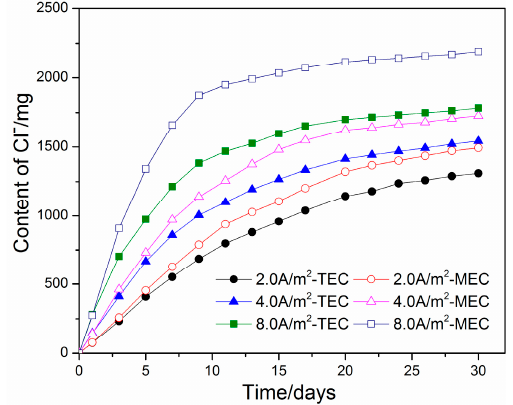
Figure 4. Cumulative amounts of chloride in the anolyte during the TEC treatment and the MEC treatment.